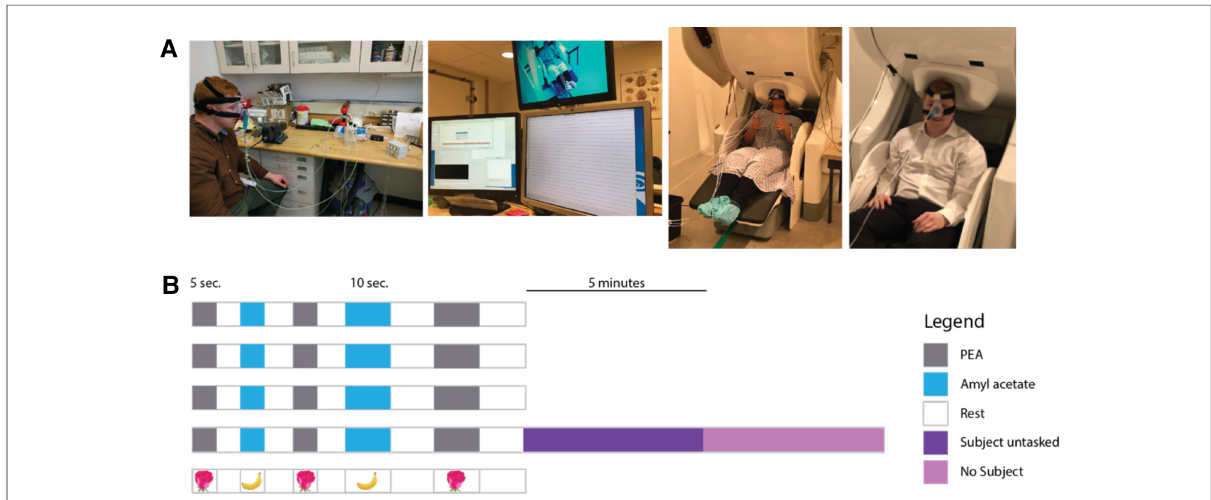
FIGURE 1 ( A ) Left: depicts the key components of the olfactometer-MEG paradigm. Subject is wearing a CPAP mask that is air sealed. Continuous room air at a constant fl ow rate is fed into one of three open solenoid valves, triggered by a software program. Air is then fed into one of three glass chambers containing PEA, amyl acetate, or odorless mineral oil. The scented air is then fed into the CPAP mask that is continuously evacuated at a constant fl ow rate. Middle: 306-channel-whole head MEG. Right: subject wearing CPAP connected to olfactometer and seated with head positioned for the MEG. ( B ) Schematic of software-programmed olfactory stimulus paradigm. Each row corresponds to a “ run. ” Four runs were performed for each subject with the last run immediately followed by MEG recording of the subject untasked (asked to relax and refrain from making any sustained, voluntary movements) and without the subject